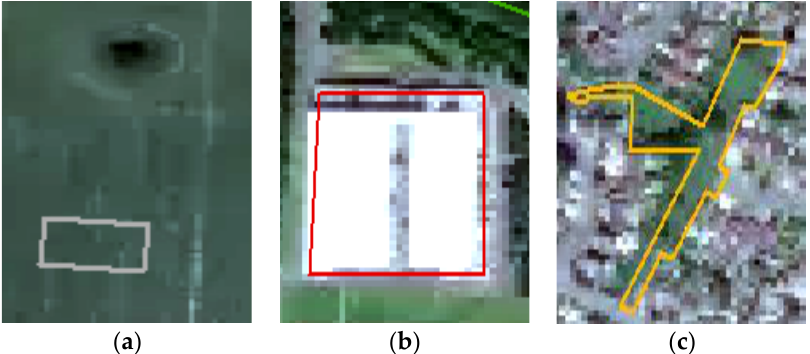
Figure 8. Overlay example graph of objects: ( a ) The object id of 4406271; ( b ) The object id of 43407756; and ( c ) The object id of 3700148. Table 4. Evaluation index score table of objects examples.